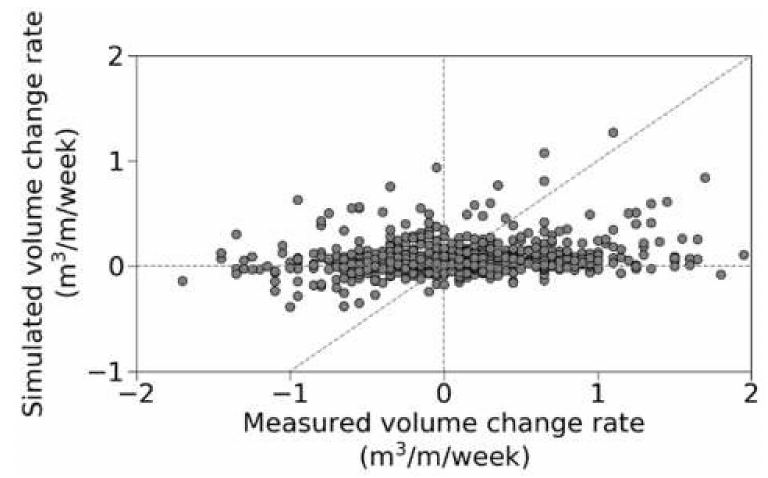
Figure 14. Correlation between the measured and simulated weekly averaged volume-change rates in the calibration